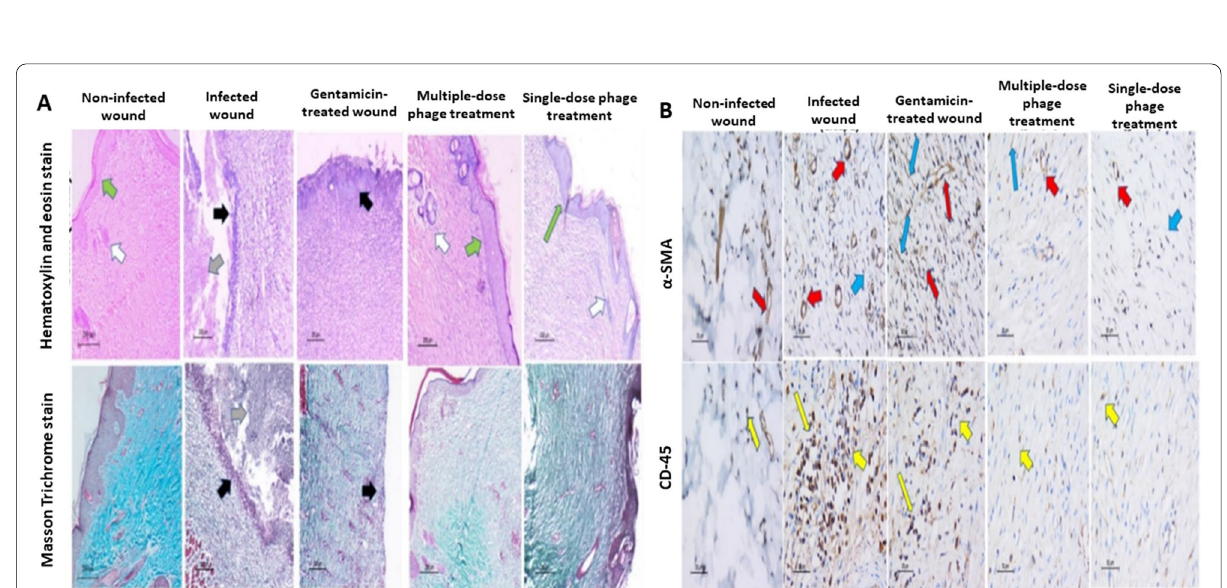
Fig. 7 Representative histopathological images of wound tissues on day 17. A Hematoxylin and eosin (H&E) staining, stain, 100, and B IHC by using α‑SMA and CD‑45, × vessels; red arrow, myofibroblasts; blue arrow, lymphocytes; yellow